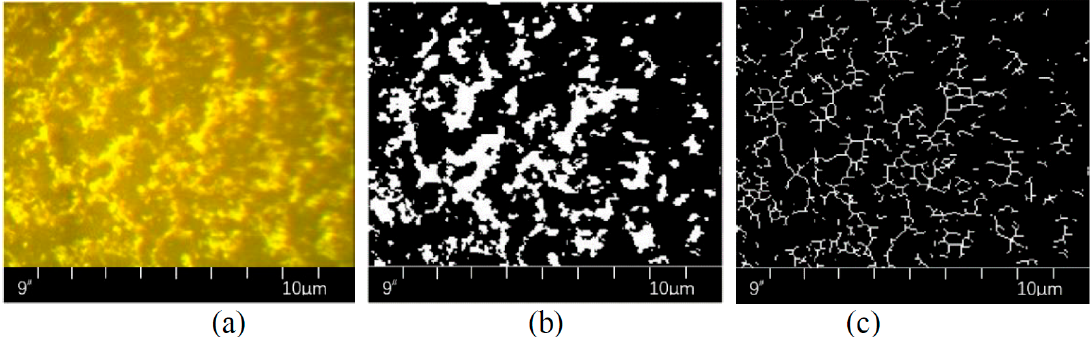
Figure 4. Image processing of: ( a ) RGB, ( b ) binary image and ( c ) skeletonized image.